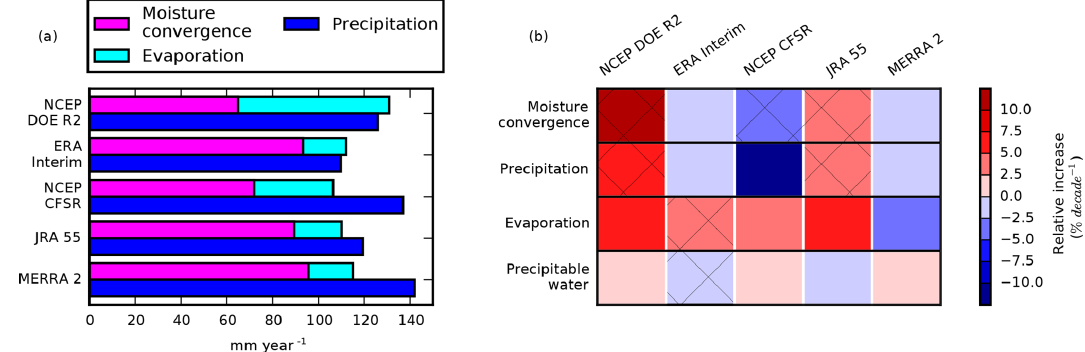
Figure 4. Magnitude of the long-term-averaged (1979–2016) atmospheric moisture budget terms of the East Antarctic ice sheet (a) . Linear trends of the moisture budget terms (b) : colour indicates rate of change and hatches statistical significance. Table 2. Magnitude of the long-term-averaged (1979–2016) atmospheric moisture budget terms in mmyr − 1 for the East Antarctic ice sheet and the whole Antarctic continent (ice-shelves excluded). The columns stand for precipitation ( P ), evaporation ( E ), convergence ( C ), net precipitation ( P - E ) and residual ( P - E - C ). Strictly speaking, the values of Arthern et al. (2006) represent accumulation rather than net precipitation. The figure for East Antarctica is a weighted average of the accumulation in the sectors from 45 ◦ W to 180 ◦ E. East Antarctica Antarctica Data